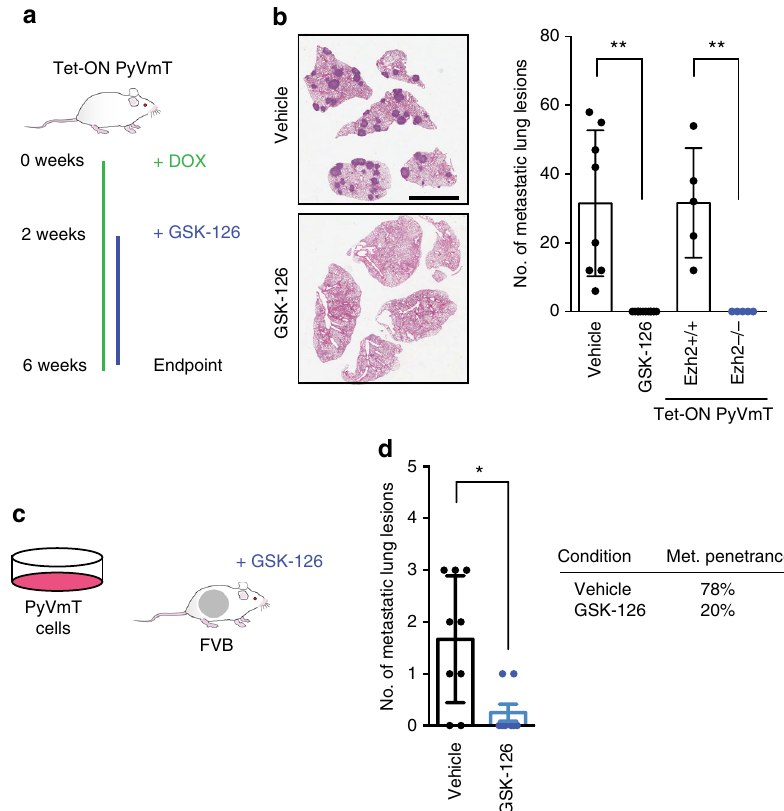
Fig. 2 Pharmacological inhibition of Ezh2 methyltransferase inhibits metastasis in vivo. a Schematic of the preclinical model. b Representative images of hematoxylin and eosin stained paraf fi n-embedded lungs from mice treated with vehicle control (Captisol) or GSK-126 (150 mg/kg) via intraperitoneal injection, three times a week. Mice were killed after 6 weeks on water supplemented with doxycycline. Enumeration of metastatic lung lesions in drug treated cohorts as outlined in the schematic, or in Ezh2 + / + or Ezh2 − / − Tet-ON PyVmT mice induced with doxycycline for 6 weeks. Scale bar is 5 mm. * p < 0.05, two tailed t -test. c Schematic of orthotopically injected PyVmT cells in an immune-competent FVB strain host. GSK-126 or Captisol vehicle control treatment commenced when tumours reached 5×5 mm. d Enumeration of lung lesions from mice treated with GSK-126 or vehicle for 24 days. * p < 0.05 ** p < 0.01, two tailed t -test. Met. penetrance, penetrance of metastatic lung